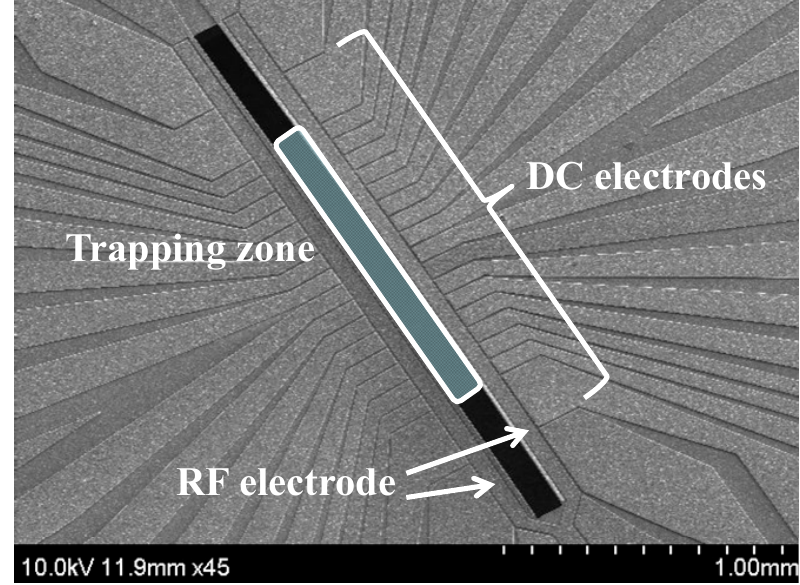
Figure 1. Scanning electron micrograph image of a surface ion trap fabricated by our group [11]. (The design layout of the ion trap uses the trap chip of Sandia National Laboratory [12] as the benchmark.)